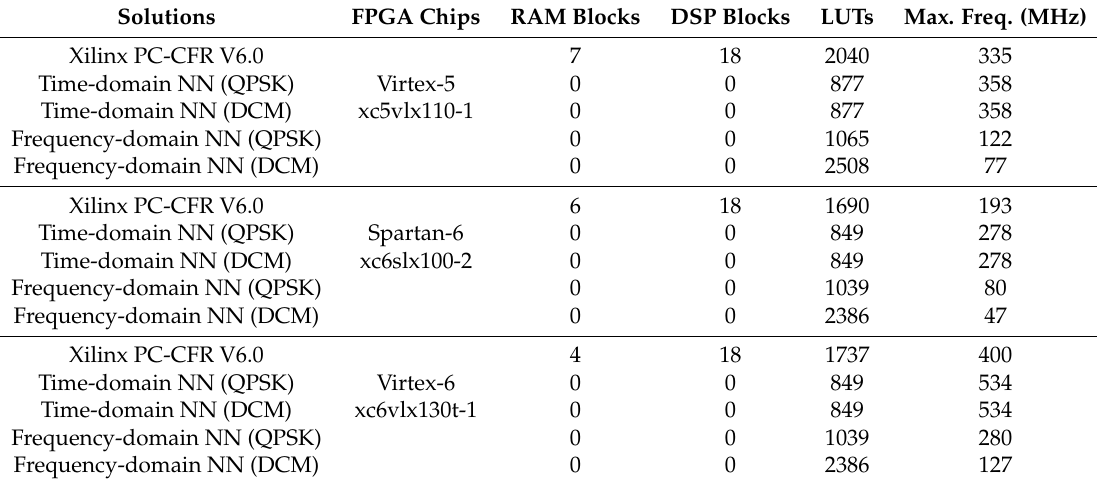
Table 5. Resource consumption in the case of Xilinx